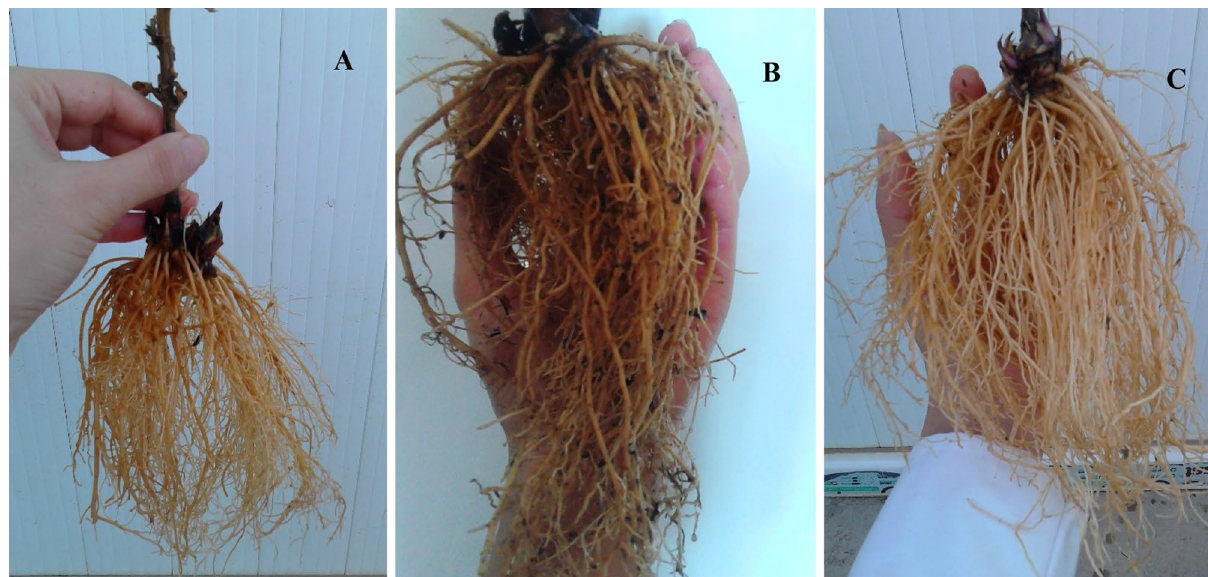
Figure 2. Root morphology of E. purpurea grown in ( A ) 100% peat moss, ( B ) 30% peat moss + 70% perlite (< 0.5 mm), ( C ) 50% peat moss + 50% perlite (< 0.5 mm) at 90:10 NO 3 − /NH 4 + ratio. The root of E. purpurea grown in 100% perlite was very small. (All photos were taken by F.